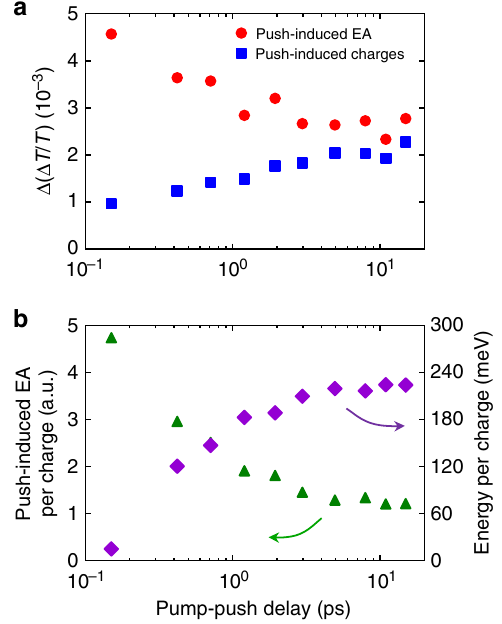
Fig. 5 Timescale for charge separation in PIPCP:PCBM. a Differential TA signal recorded between 0.25 and 0.50 ps after the push pulse as a function of pump-push delay for the push-induced EA ( λ ~ 850 nm) and the push-induced charges ( λ = 1150 – 1200 nm). Note that the latter includes both CT states and separated charges. b Push-induced EA on a per charge basis and the energy per charge stored in the dipolar electric fi eld resulting from CT state separation as a function of pump-push delay NATURE COMMUNICATIONS | 8: